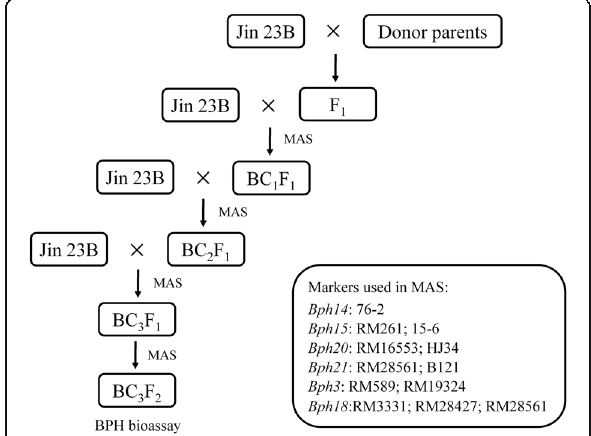
Fig. 1 Scheme of marker-assisted backcross breeding used in the current study. Donor parents included 4 cultivars: PTB33 ( Bph3 ), B5 ( Bph14 / Bph15 ), IR65482 – 7 – 216-1-2 ( Bph18 ) and IR71033 – 121-15 ( Bph20 / Bph21 ). MAS: marker-assisted